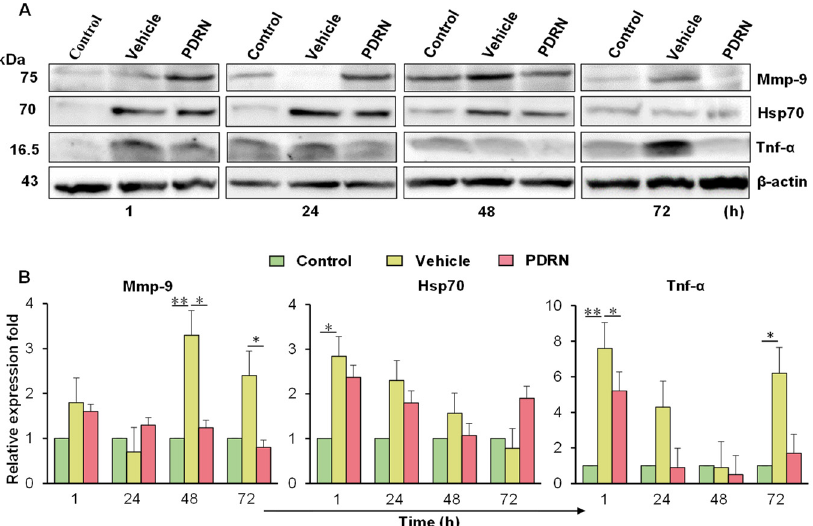
Figure 6. Immunoblot analysis of Mmp-9, Hsp70, and Tnf- α in response to corneal injury and PDRN treatment in zebrafish eye. ( A ) Western blot analysis images representing the specific protein bands that were expressed against the selected antibodies. ( B ) The pixel intensity of each protein band was quantified using Chemi Doc (Fusion Solo, Vilber, Lourmat, France) and normalized to β -actin. The relative expression fold was calculated based on the control group of each time point (one-way ANOVA was performed to find statistical significance; * p < 0.05; ** p <